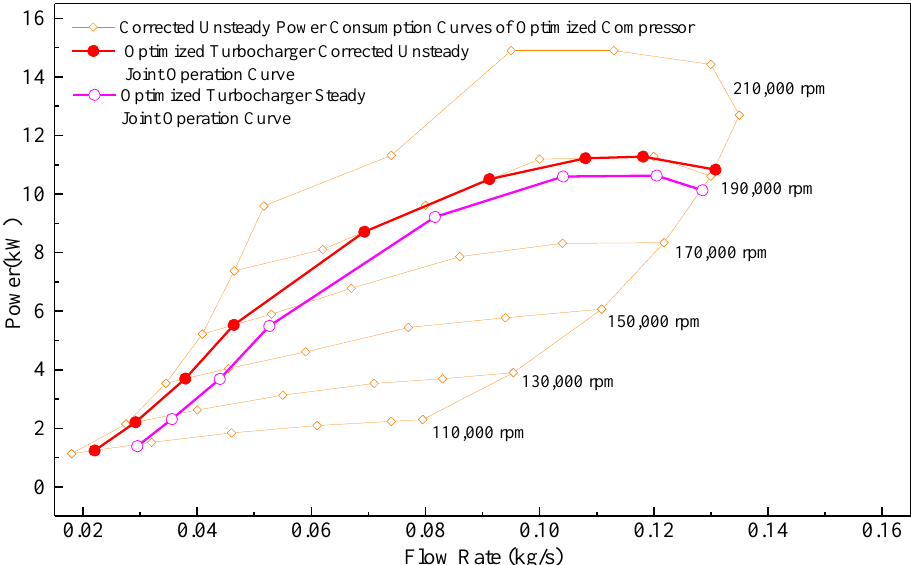
Figure 13. The optimized turbocharger corrected internal joint operation curves.